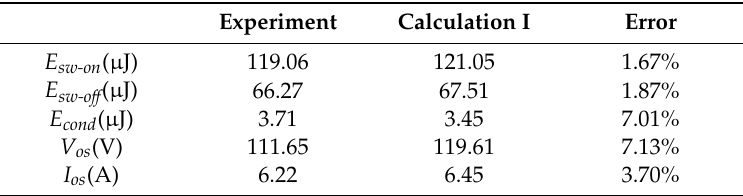
Figure 11. Comparison of switching waveforms between experiment and analytical model. ( a ) Turn-on switching waveform. ( b ) Turn-o ff switching waveform. Table 5. Quantitative comparison of loss, voltage and current overshoot.